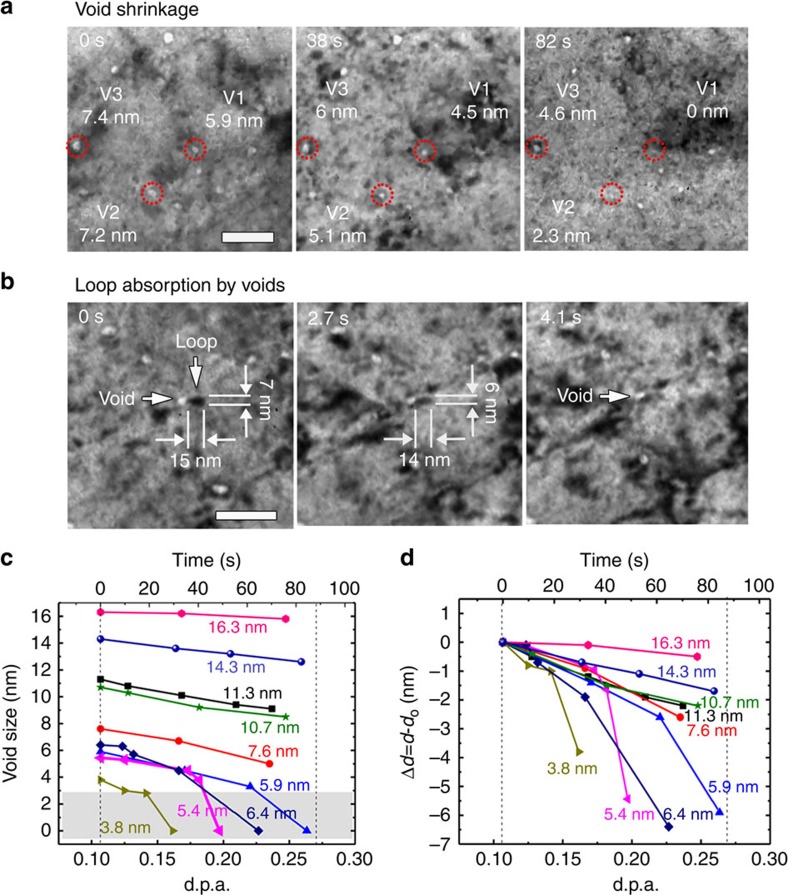
In situ Kr ion irradiation studies of nv-nt Cu unravelling continuous shrinkage of nanovoids and absorption of mobile dislocation loops by nanovoids.(a) In situ snapshots revealing shrinkage of numerous nanovoids over 0.11–0.26 d.p.a. At 0 s, 3 voids (V1-V3) with respective diameters of 5.9, 7.2 and 7.4 nm were tracked. At 82 s, V1 disappeared completely, while V2 and V3 decreased to 2.3 and 4.6 nm, respectively. Scale bar, 50 nm. (b) Sequential snapshots capturing the absorption of dislocation loops by voids over 0.13–0.14 d.p.a. (see Supplementary Movie 1 for detail). At 2.7 s, the loop was partially absorbed by the void. By 4.1 s, a complete absorption of the dislocation loop was observed. Scale bar, 50 nm. (c) Compiled chart showing the shrinkage of nanovoids with different diameters during in situ radiation. While larger voids shrank continuously during radiation, the rate of shrinkage is clearly greater for smaller nanovoids. When void diameter reduced to ∼3 nm (marked as grey band), there appeared to be an accelerated collapse of these tiny nanovoids, that is these voids vanished nearly instantaneously. (d) The evolution of reduction of void diameter Δd=d−d0 with radiation dose and time, where d0 is the original void diameter.